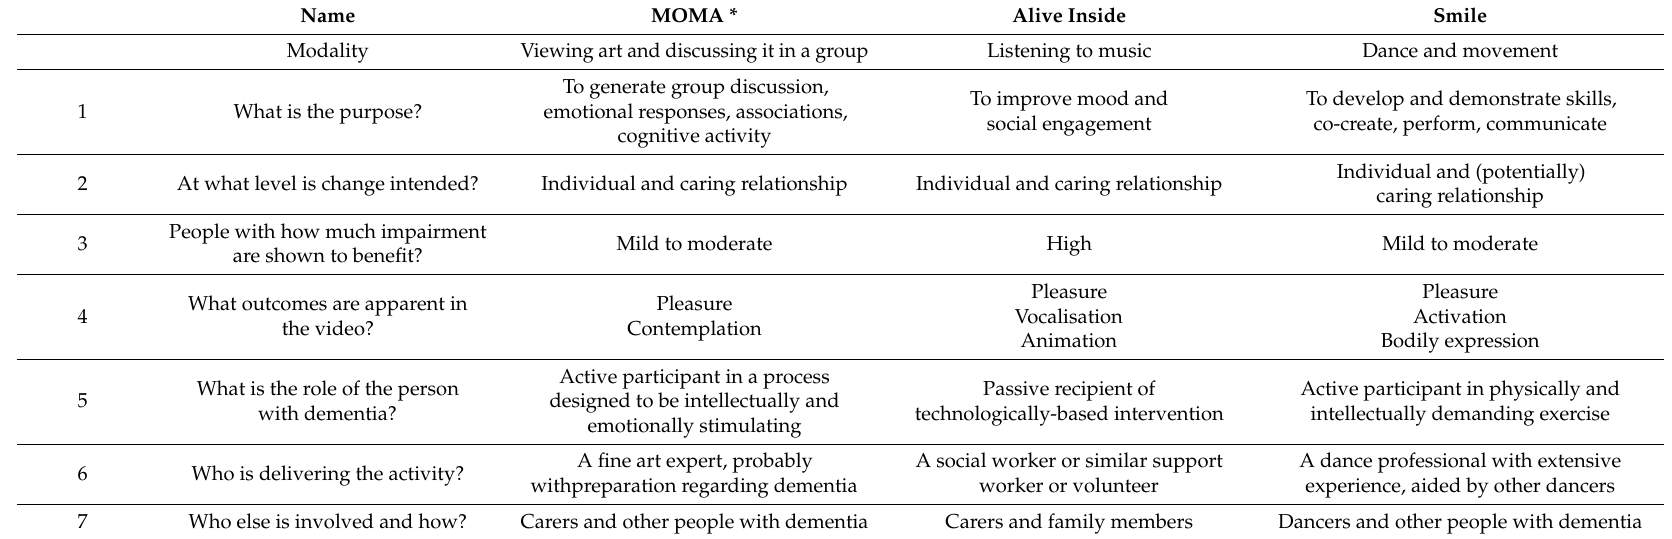
Table 2. Characterising three arts interventions on seven